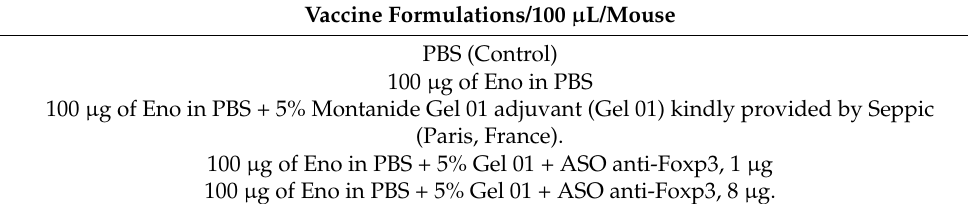
Table 1. Vaccines